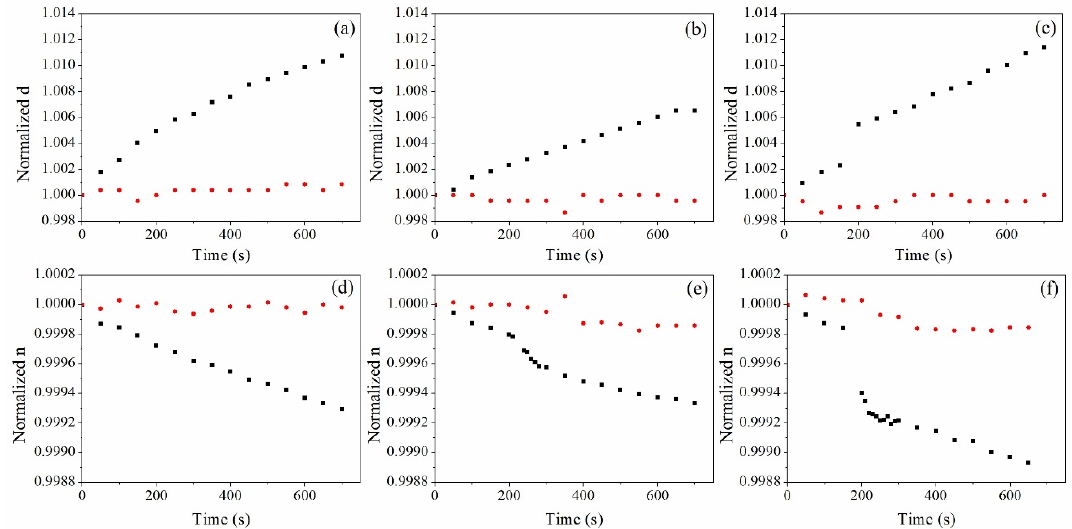
Figure 3. (Top row) normalized thickness, d , as a function of exposure time to 0 ( a ), 2 ( b ) and 4 ( c ) mM Cu 2 + solution; (bottom row) normalized refractive index, n , as a function of exposure time to 0 ( d ), 2 ( e ) and 4 ( f ) mM Cu 2 + solution. Black square symbol represents tetraethyl orthosilicate (TEOS)-LTL data, and red spheroidal symbol represents TEOS-only data.